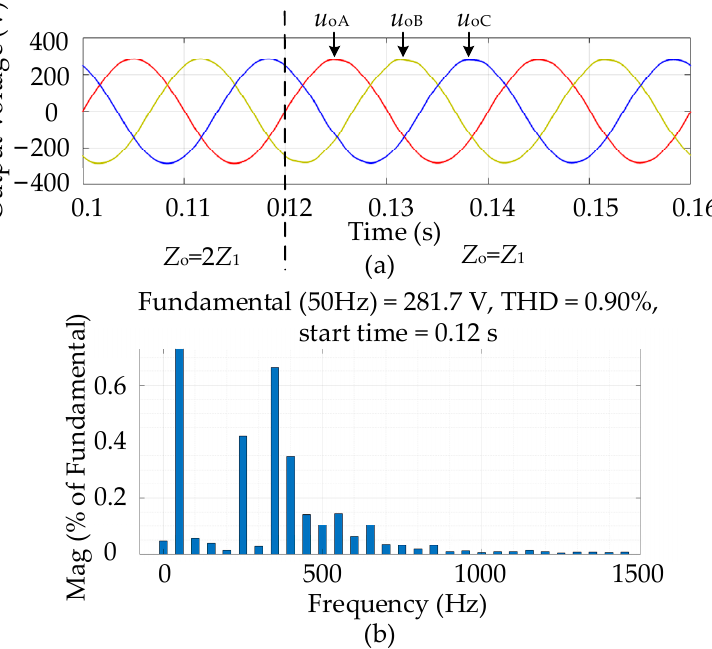
Figure 19. ( a ) The output voltage of each phase during a resistive–inductive load transient. ( b ) The FFT result of the A-phase output voltage.